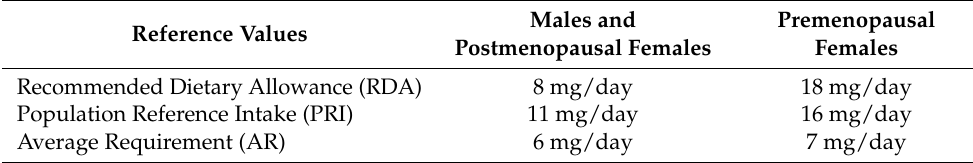
Table 1. Dietary reference intake recommendations for